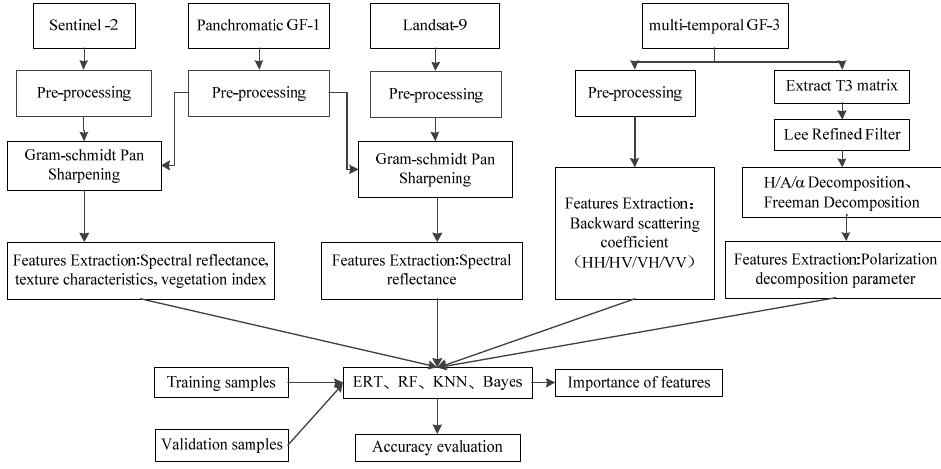
Figure 3. Methodological framework for mangrove species identification.